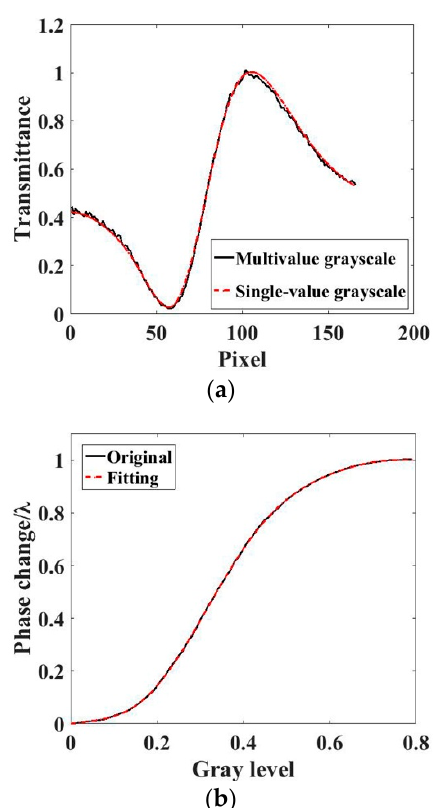
Figure 6. ( a ) Transmittance as a function of the grayscale. ( b ) Phase change as a function of the grayscale.